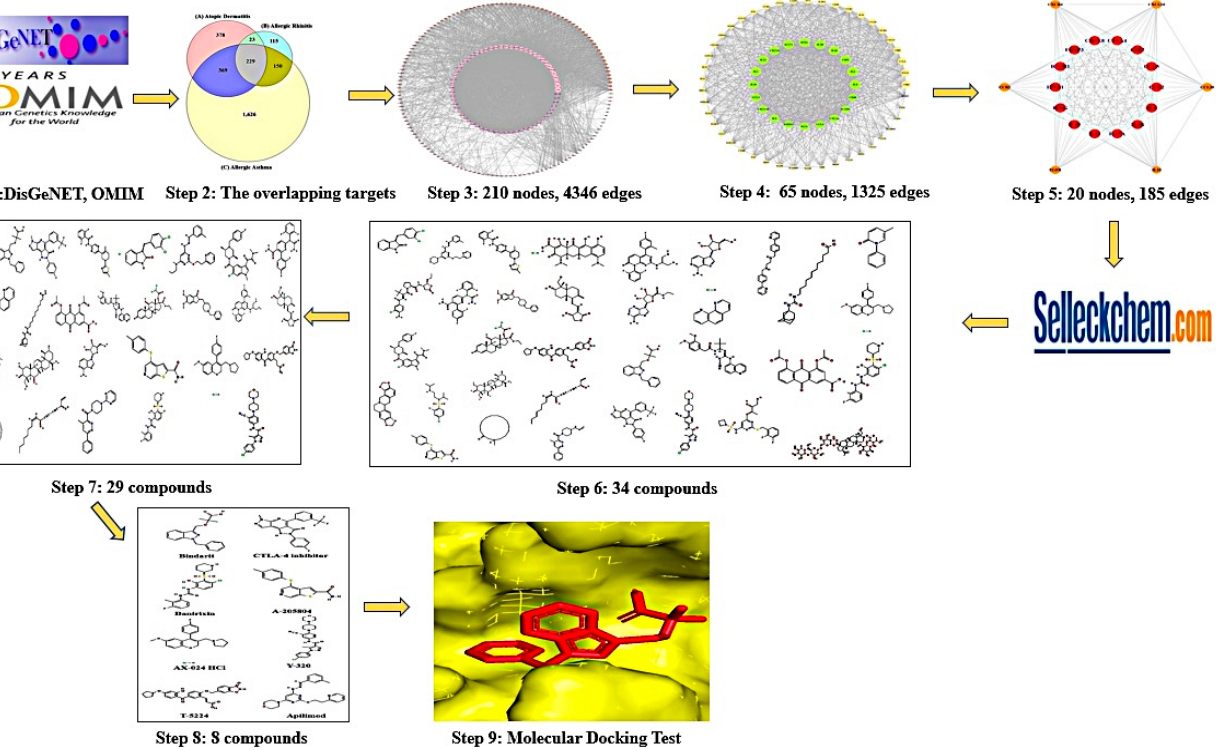
Figure 1. The workflow of this study.